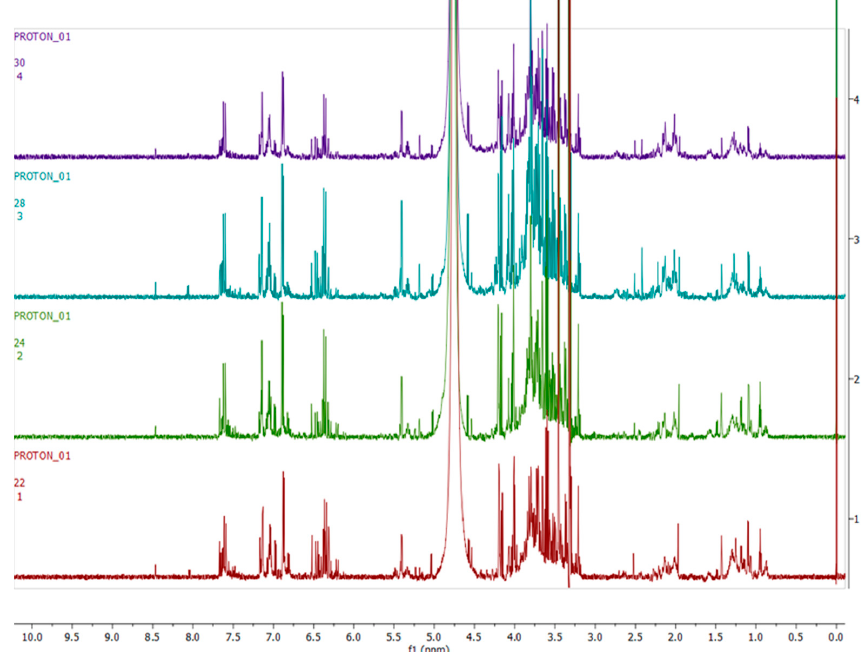
Figure 5. Comparison between samples harvested from wet sites in the autumn season across the two locations on the basis of 600 MHz 1 H-NMR spectra of H. aureonitens leaf extracts. Red—autumn season, site 1 (wet) Telperion; green—autumn season, site 2 (wet) Telperion; light blue—autumn season, site 1 (wet) Wakefield; purple—autumn season, site 2 (wet) Wakefield.